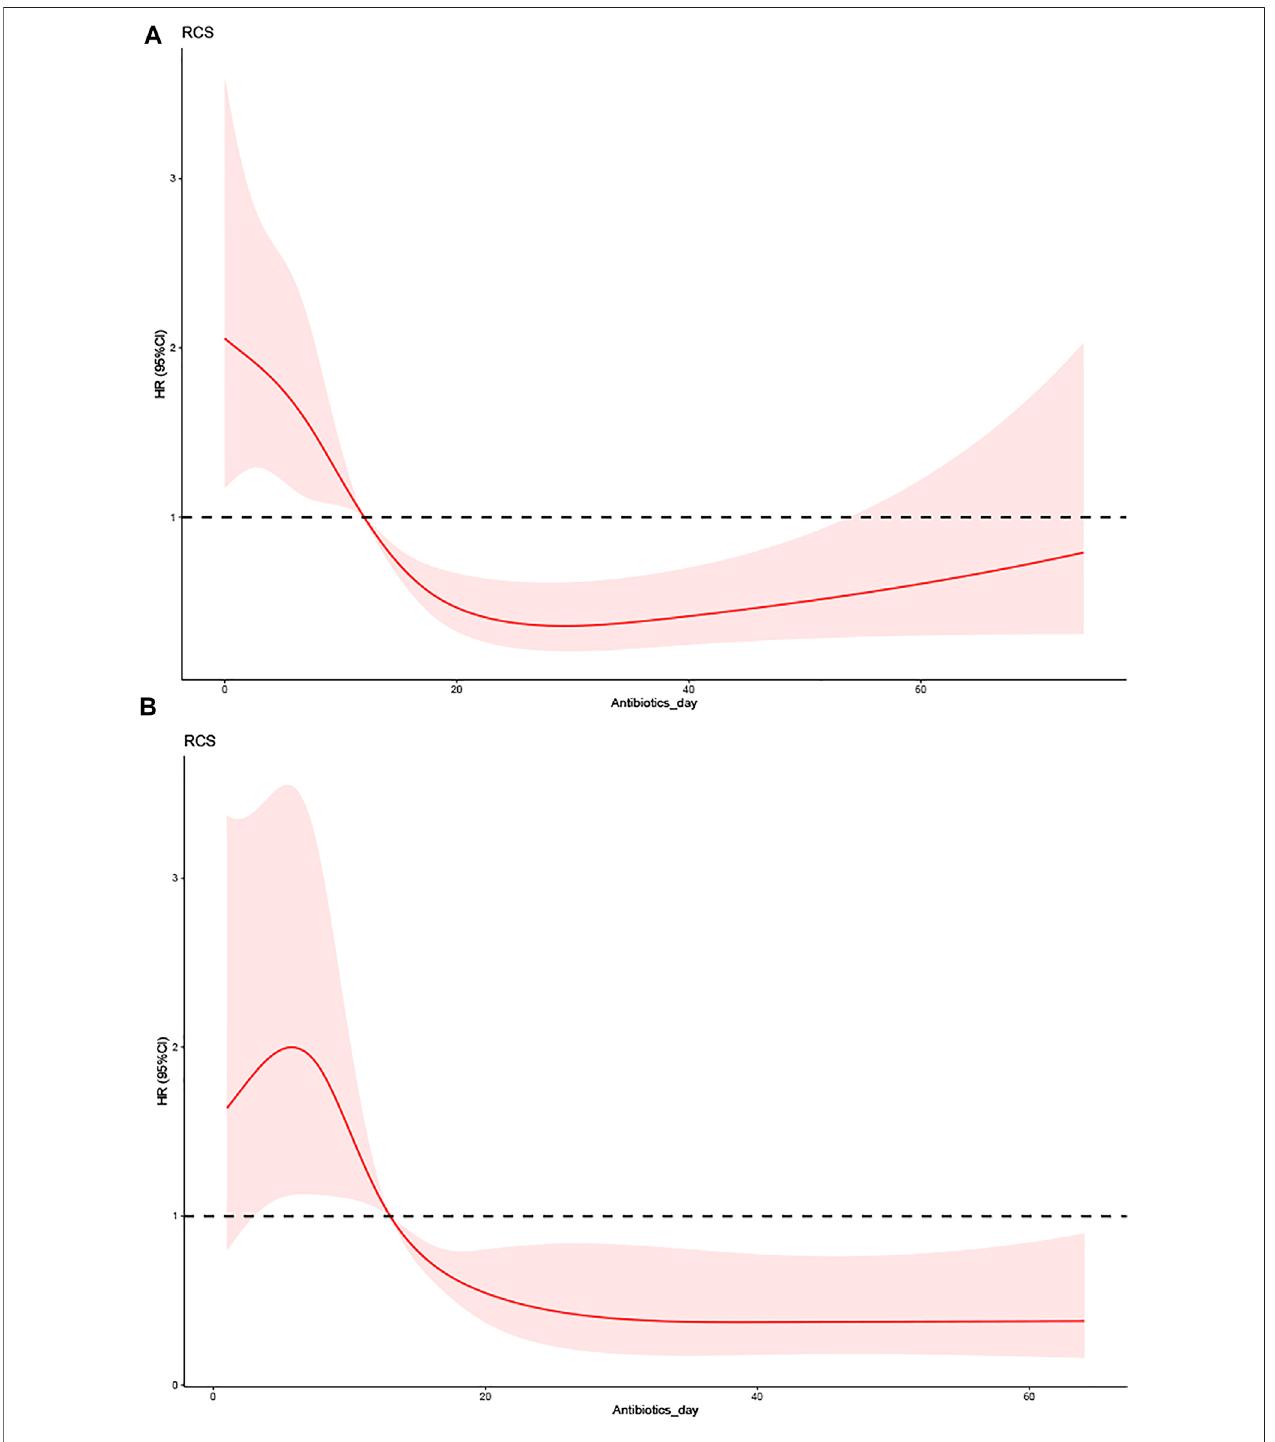
FIGURE 3 | The effect of the duration of antibiotic use on the prognosis of VAP between different BMI groups. (A) Low-BMI group (BMI < 30 kg/m2). (B) High-BMI group (BMI ≥ 30 kg/m2).